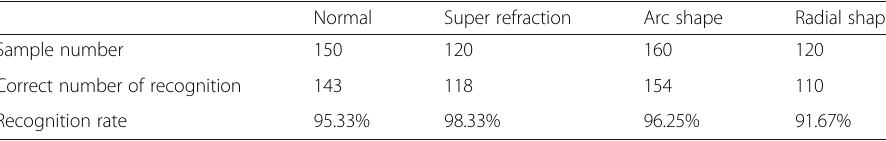
Table 5 The recognition accuracy of testing samples